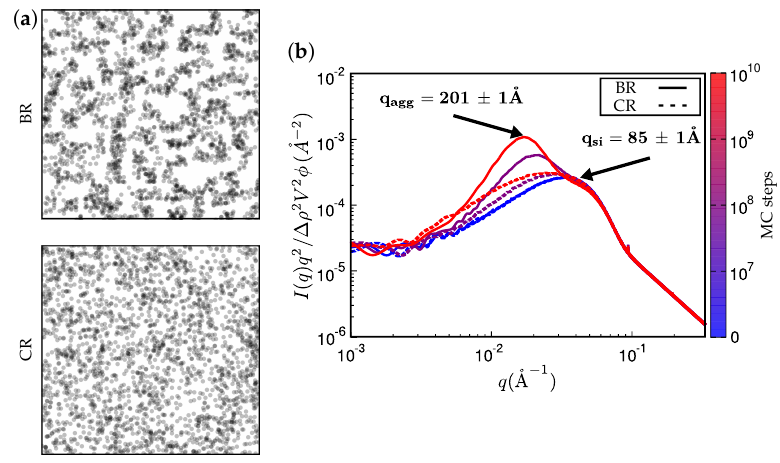
Figure 12. ( a ) simulated TEM images. ( b ) attendant simulated SAXS curves. Here, the filler is Ultrasil VN3 gran., as in one of the systems in the previous figure. The rubber is alternatively BR or CR. System parameters were not